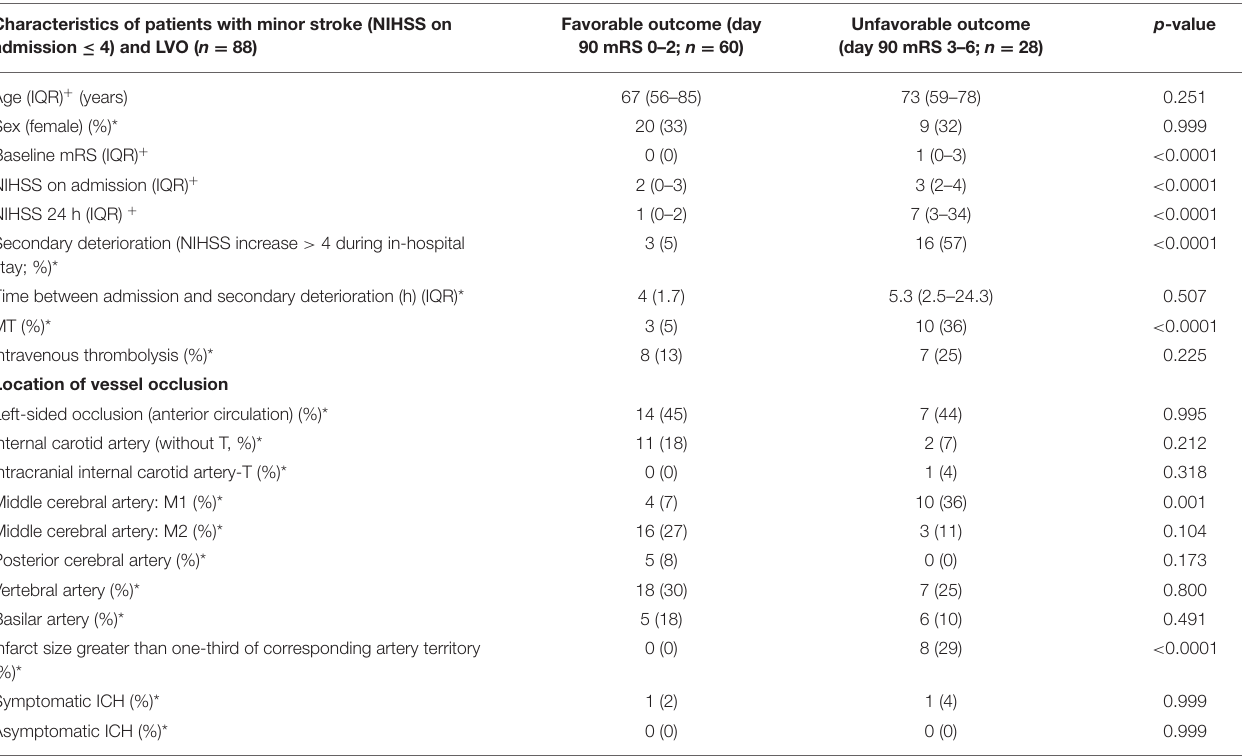
TABLE 2 | Characteristics of patients with minor deficits (NIHSS ≤ 4 on admission) and LVO stratified for outcome (favorable = day 90 mRS 0–2; unfavorable = day 90 mRS 3–6). Characteristics of patients with minor stroke (NIHSS on admission ≤ 4) and LVO ( n = 88)